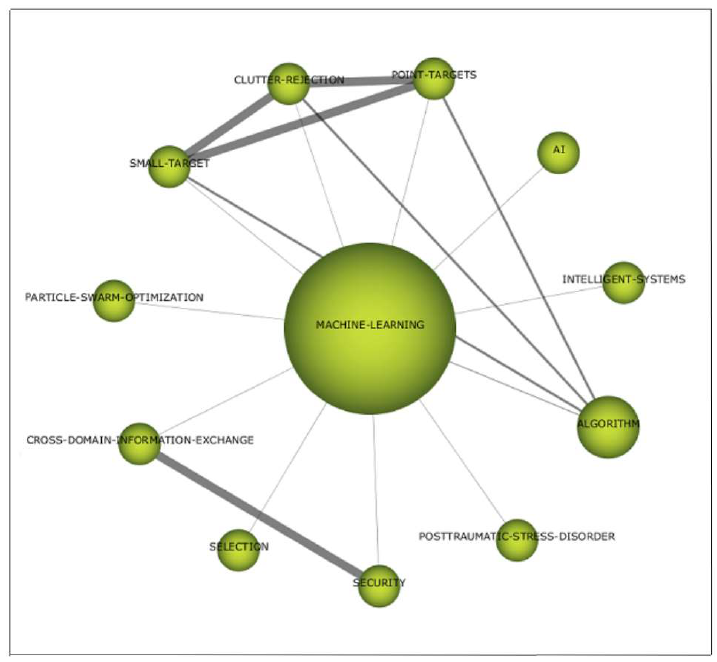
Figure 8. Network by co-occurrence; ML; Period to 2015.